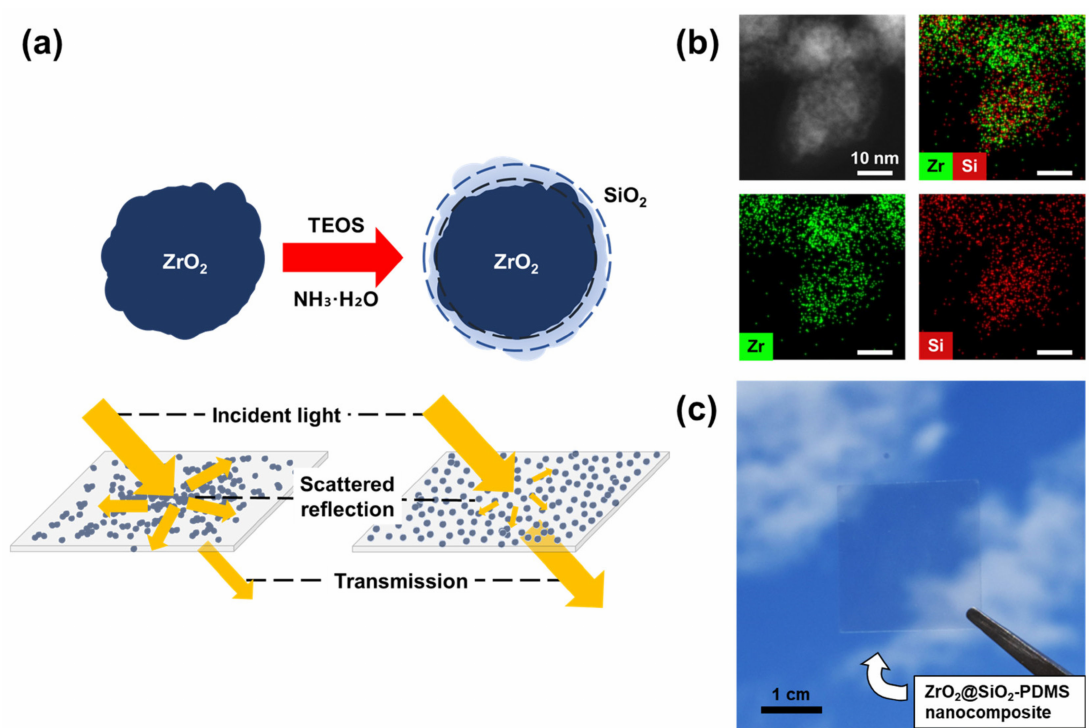
Figure 1. ( a ) Schematic illustration of surface modification of ZrO 2 NPs using TEOS to prepare a transparent nanocomposite film with adjustable refractive index. ( b ) TEM-EDX images of ZrO 2 @SiO 2 NPs indicating that the surface of ZrO 2 NPs was modified with the SiO 2 layer. ( c ) Photo of ZrO 2 @SiO 2 - PDMS nanocomposite film (100 nm thickness) containing 50 wt% ZrO 2 @SiO 2